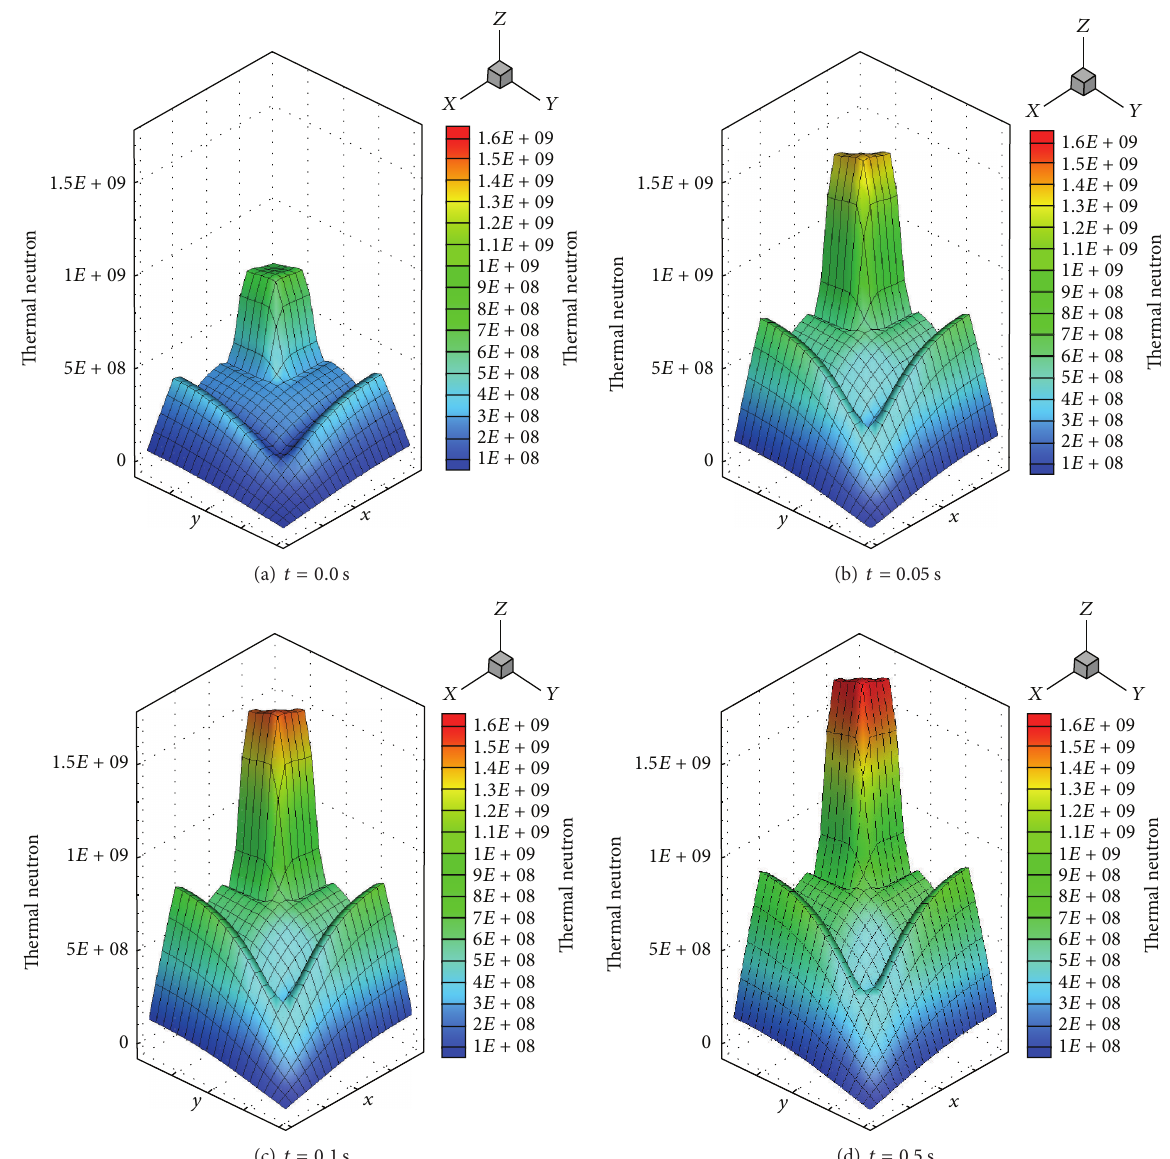
Figure 7: Thermal neutron flux distribution versus time in TWIGL problem during step